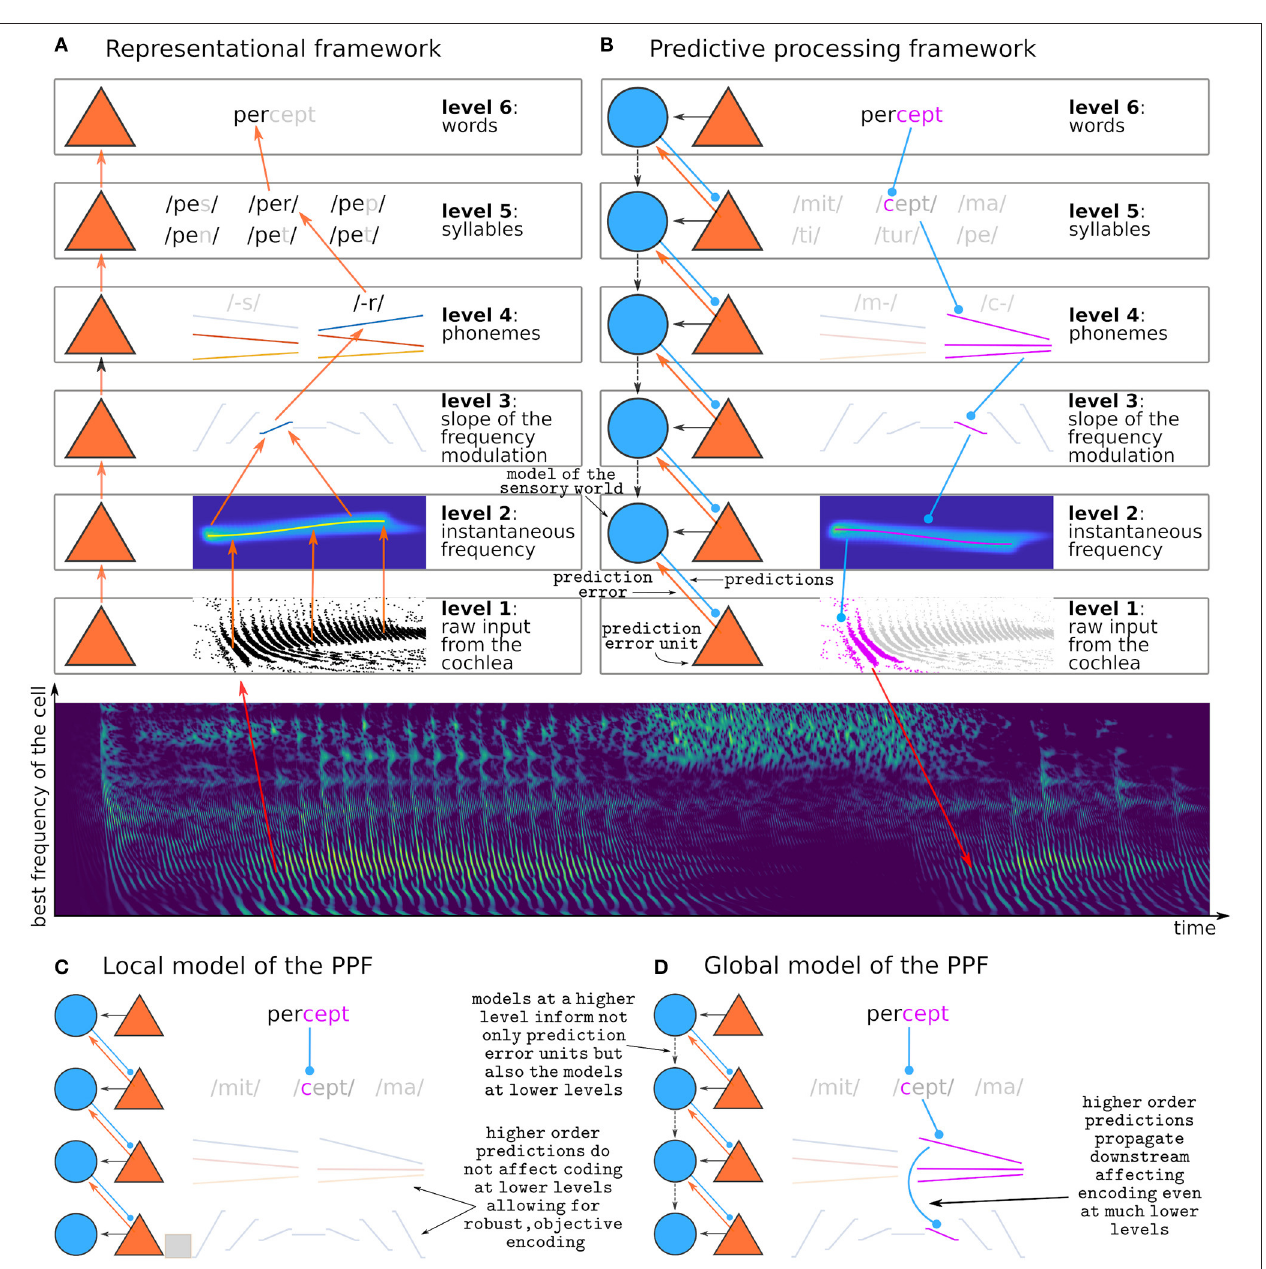
FIGURE 1 | Representational and predictive processing frameworks. (A) Schematic view of a possible implementation of the representational framework during the decoding of the syllable /per-/ . (B) Schematic view of a possible implementation of the predictive processing framework while performing predictions on the incoming syllable /-cept/ . Purple features are predictions. The middle panel depicts a simulation of the neural activity in the auditory nerve across the tonotopic axis ( y -axis) elicited by the spoken word percept . (C) Example implementation of the local model: whereas predictions at the word level are used to encode prediction error at the immediately lower level as formulated by the PPF, predictions are not used to calculate the predictive model of the lower stages, and thus the remaining levels depend on bottom-up information only. (D) Example implementation of the global model: predictions at the word level propagate downwards affecting the predictive model of all stages (dashed descending arrows), so that prediction error at the lowest level is encoded with respect to a model that is ultimately defined in the highest level. Intermediate implementations where interactions between the models exist up to a certain level only are also possible but not displayed here. Note that (B) depicts the global